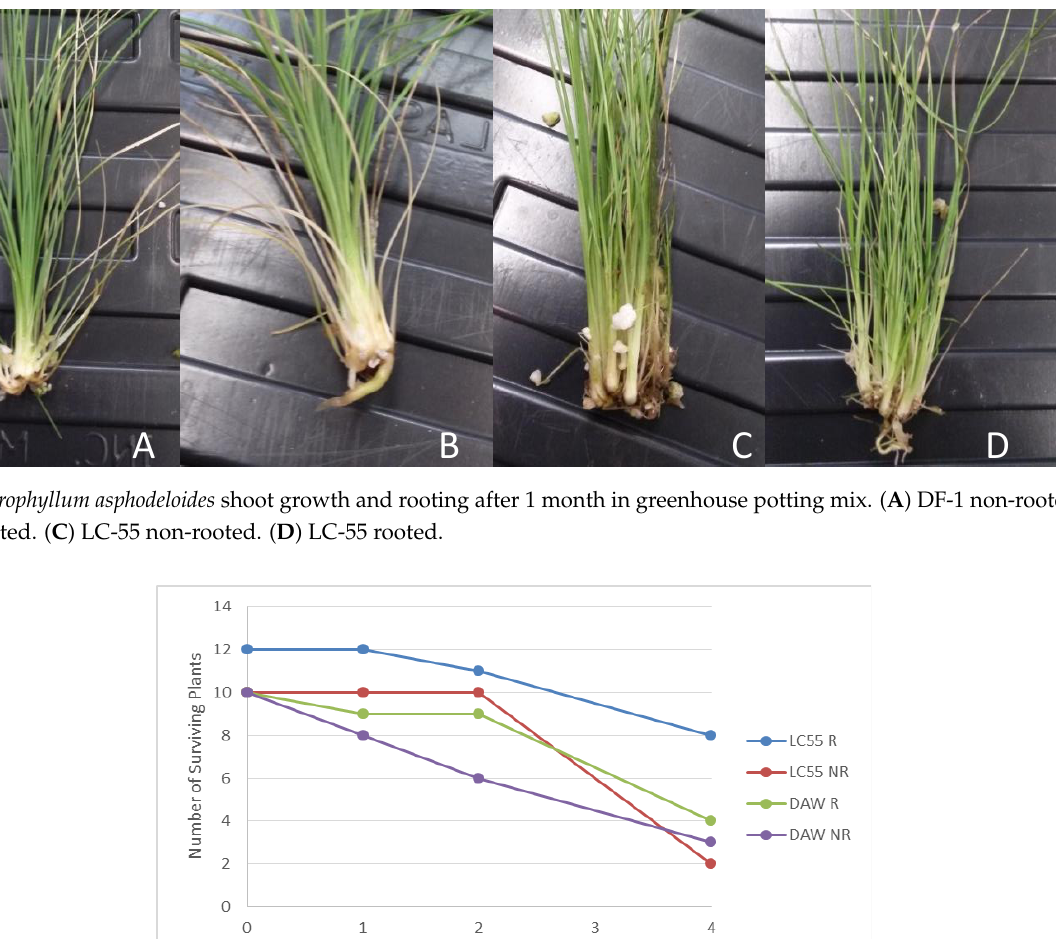
Figure 6. Xerophyllum asphodeloides micropropagated shoot survival over time for two clones planted in greenhouse soil. R (shoots with roots at the time of planting), NR (without roots when